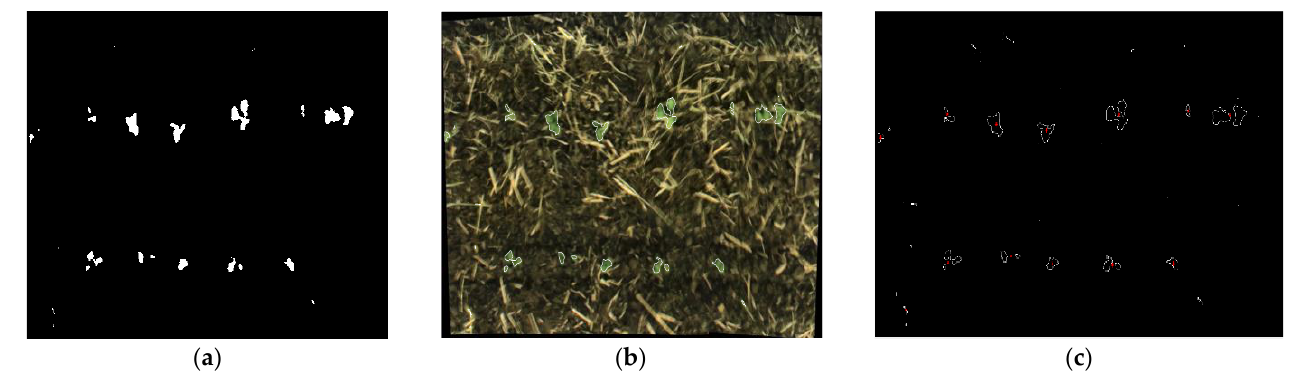
Figure 4. Morphological processing contrast image. ( a ) Morphological processing image, ( b ) Edge image, ( c ) Averaging algorithm to annotate image.